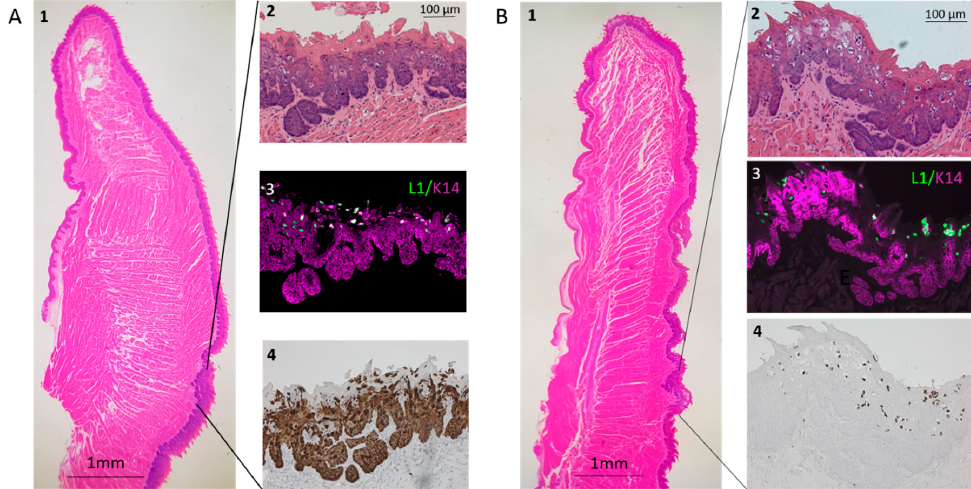
Figure 4. Infection of the base of the tongue with MmuPV1 elicits dysplastic lesions that express viral protein. Lesions developed at the targeted infection site approximately 2/3 of the distance from the rostral tip to the caudal end of the tongue, approximately 1–2 mm caudal of the median eminence. ( A ) Panel 1: The tongue of a nude mouse collected 21 weeks after infection with 3 × 10 9 genome equivalents of MmuPV1. Lines demark the dysplastic epithelium shown in Panel 2, stained with H&E; Panel 3, after L1 and K14 IHC; and Panel 4, in situ hybridization with probes for MmuPV1 E6 and E7. ( B ) Panel 1: The tongue of an NSG mouse collected 21 weeks after infection with 8 × 10 9 genome equivalents of MmuPV1. Lines demark the dysplastic epithelium shown in Panel 2, stained with H&E; Panel 3, after L1 and K14 IHC; and Panel 4, after in situ hybridization with probes for MmuPV1 E6 and E7.